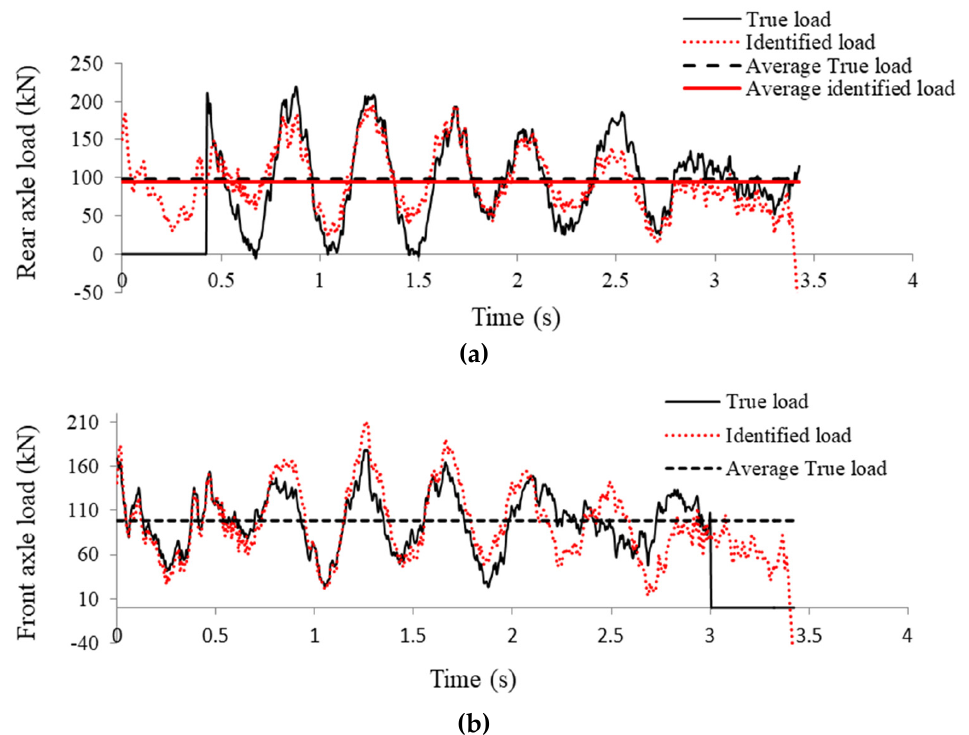
Figure 6. Identified loads at road roughness level C at a of speed 10 m/s and with 2% noise: ( a ) rear axle load identification, ( b ) front axle load identification.